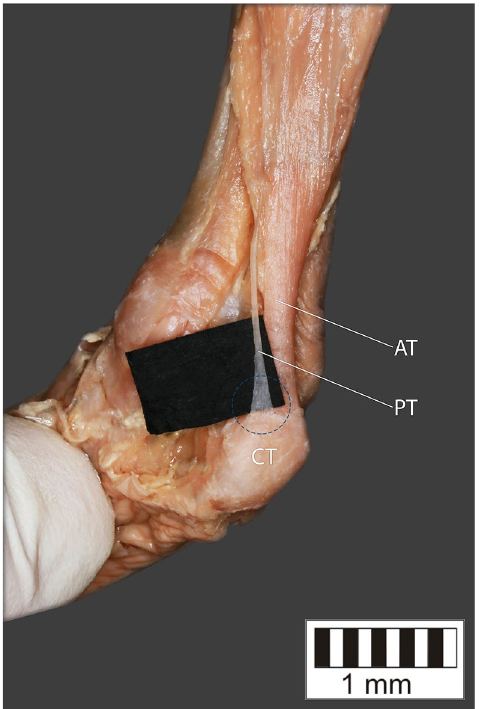
Figure 3. Type I of plantaris tendon. CT calcaneal tuberostity, AT Achilles tendon, PT plantaris tendon.